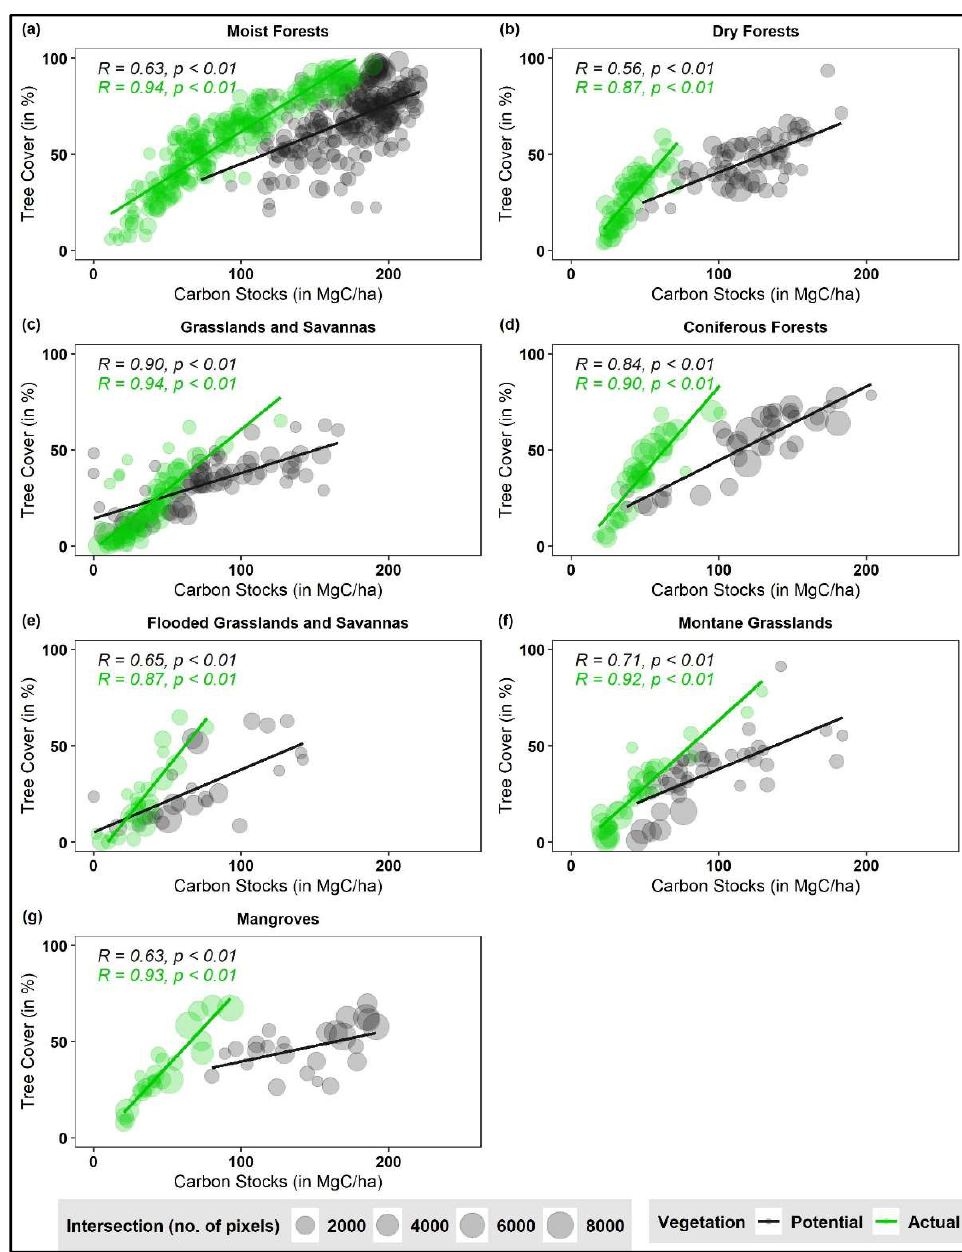
Figure 4. Tree cover (TC)—biomass carbon stocks (CS) correlations across tropical biomes ( a–g ) for both potential (in black) and actual (in green) vegetation. Each circle denotes the zonal average of potential and actual TC and CS for the ecozone represented by the intersection of three potential vegetation maps within each biome ( n = 494). We exclude areas where number of pixels within each ecozone, n < 10 as outliers. The circle size is proportional to the areal extent of the biome.